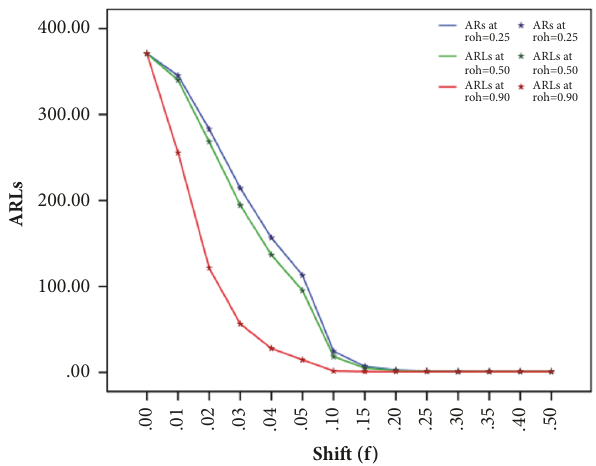
Figure 12: ARLs for proposed repetitive EWMA-RSS control chart using Khan et al. [8] ratio estimator, when 𝑟 𝑜 = 370 at 𝜆 = 0.3.